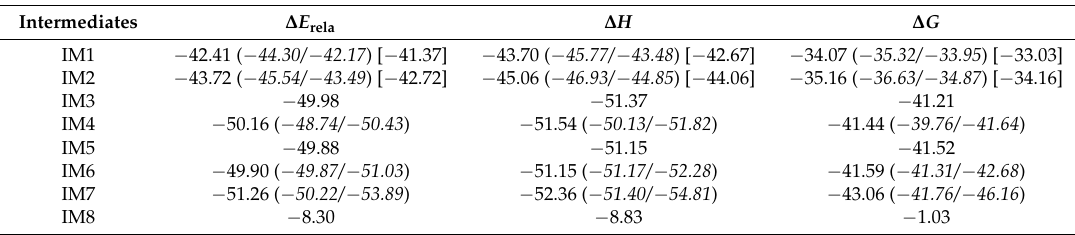
Table 1. Calculated relative energies ( ∆ E rela ) and the enthalpy and Gibbs free energy changes ( ∆ H and ∆ G) in the formation process of initial intermediates a.